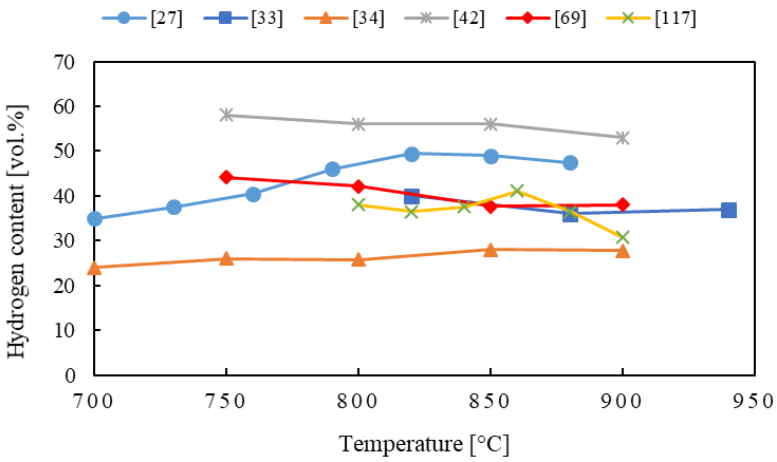
Figure 10. Hydrogen concentration as a function of fuel reactor temperature.